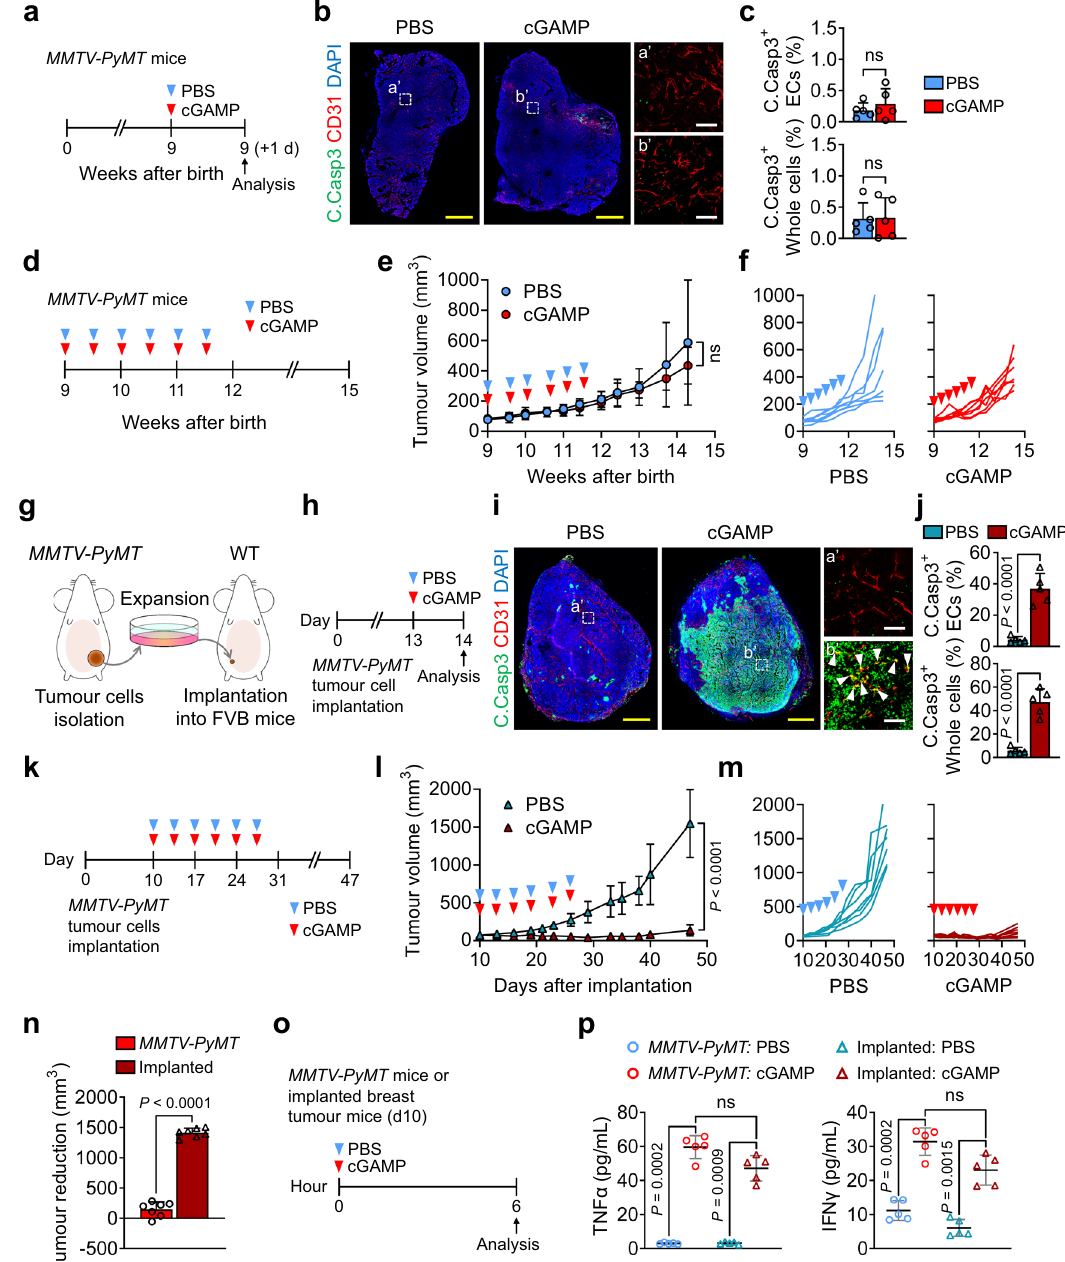
Fig. 6 cGAMP fails to induce tumour EC apoptosis and anti-tumour growth in MMTV-PyMT spontaneous breast cancer. a – c Diagram depicting treatment and sampling in 9 weeks-old MMTV-PyMT mice. Representative images and comparisons of apoptosis in tumour ECs and whole tumour cells (whole cells). Scale bars, 1.0 mm (yellow bars) and 100 μ m (white bars). n = 5 mice/group from two independent experiments. Vertical bars indicate mean ± SD. d – f Diagram depicting treatment and sampling in 9 weeks-old MMTV-PyMT mice. Comparison of tumour growths. n = 7 mice/group from two independent experiments. Plots and bars indicate mean ± SD. Plot indicates each individual tumour growth. g Diagram depicting generation of an orthotopic implanted breast tumour in syngeneic FVB mice. h - j Diagram depicting treatment and sampling in implanted breast tumour mice. Representative images and comparisons of apoptosis in tumour ECs (white arrowheads) and whole tumour cells. Scale bars, 1.0 mm (yellow bars) and 100 μ m (white bars). n = 5 mice/group from two independent experiments. Vertical bars indicate mean ± SD. k – m Diagram depicting treatment and tumour growth in implanted breast tumour mice. Comparisons of tumour growths. n = 7 mice/group from two independent experiments. Plot and bars indicate mean ± SD. Plot indicates each individual tumour growth. n Comparison of reduction of tumour volume by cGAMP treatment between spontaneous and implanted breast tumours at day 47 after the implantation. o , p Diagram depicting treatment and sampling 6 h later in 9-week-old MMTV-PyMT mice and its implanted breast tumour mice 10 day (d10) after implantation. Comparisons of TNF α and IFN γ levels in tumour lysates. n = 5 mice/group from four independent experiments. Horizontal bars indicate mean ± SD. P values by two-tailed t-test ( c , e , j , l , n ) or Welch ’ s one-way ANOVA test followed by Dunnett ’ s T3 test ( p ). ns, not signi fi cant. Source data are provided as a Source Data fi